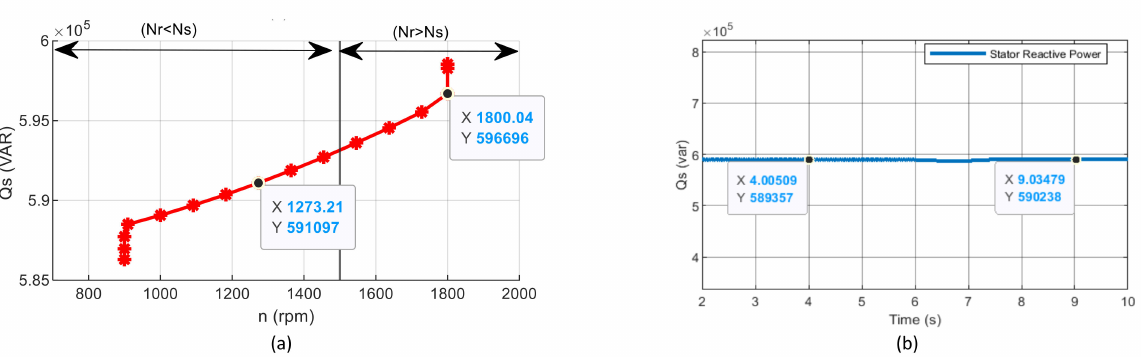
Figure 13. ( a ) Calculated stator reactive power; ( b ) Stator reactive power of the designed system. The rotor reactive power in Figure 14b changes from 14.067 kVAR to − 64.57 kVAR to meet the reactive power demands during subsynchronous and super-synchronous conditions. The values are comparable to the calculated values of 12.4827 kVAR and − 69.5111 kVAR in Figure 14a.